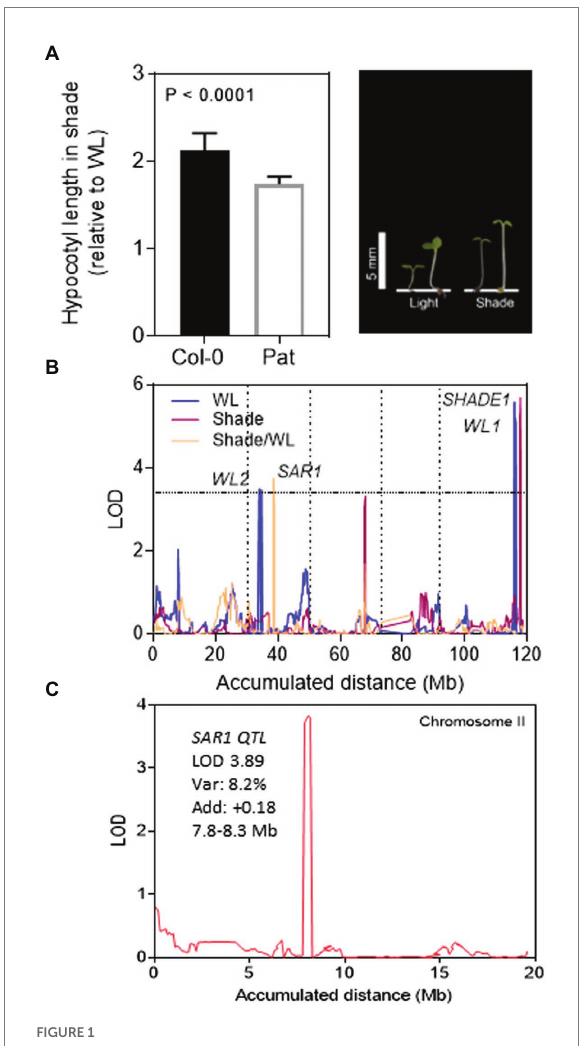
FIGURE 1 QTL mapping for shade avoidance response in Col-0 and Pat RIL population. (A) SAR index for Col-0 and Pat seedlings calculated as the ratio of hypocotyl length in simulated shade and WL. The photo shows representative Col-0 (left) and Pat (right) seedlings in WL and simulated shade. (B) QTL mapping for hypocotyl growth in WL, simulated shade, and SAR index in the Col-0 and Pat RIL population. LOD score is shown for the accumulated distance of the five chromosomes separated by vertical dashed lines. The horizontal dashed line indicates the LOD significance threshold value. (C) LOD score is shown for the absolute distance of chromosome II (Mb). PHYB is the candidate gene mapped into the confidence interval of SAR1 QTL. For SAR1 QTL, is indicated the LOD, % explained variability, additive effects (positive additive effects mean a higher contribution of Col-0 alleles) and confidence